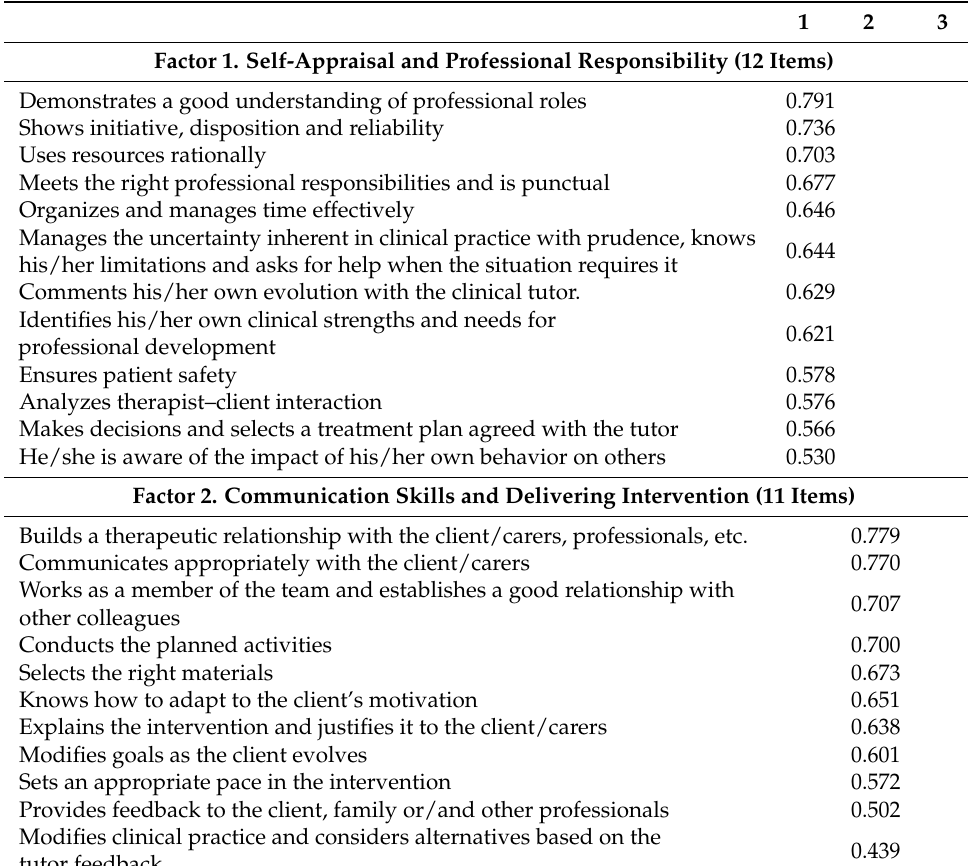
Table 1. Exploratory factor analysis (33